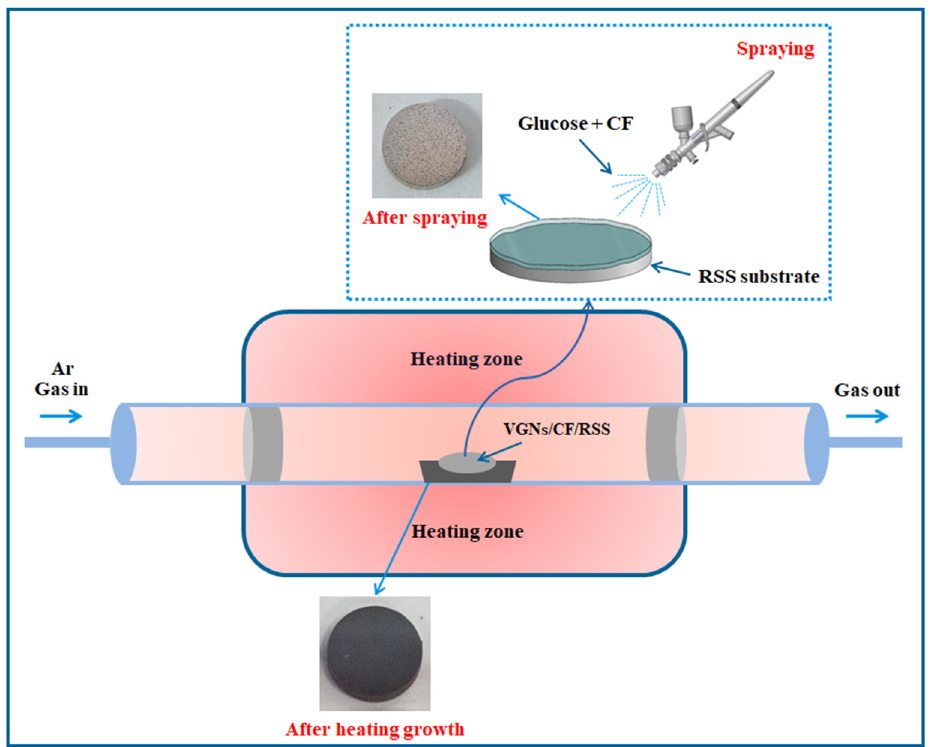
Figure 1. Schematic diagram of VGNs/CF composite films preparation